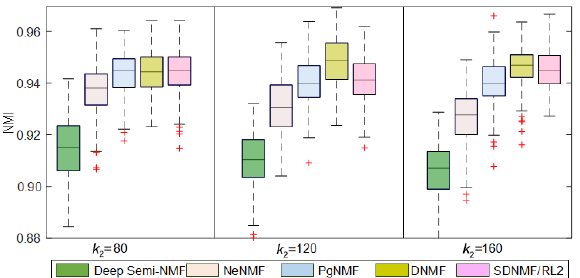
Fig. 2 Comparison of PgNMF, NeNMF, deep semi-NMF, DNMF, and SDNMF/RL2 in terms of NMI under different k 2 . Under each k 2 , we chose the best k 1 among 100, 200, 300, 400, 500, 600, 700, and 800 for each deep model.